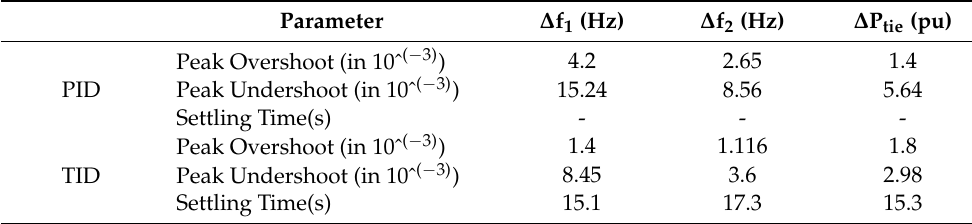
Table 7. Comparison of dynamic measures with PID and TID controllers.